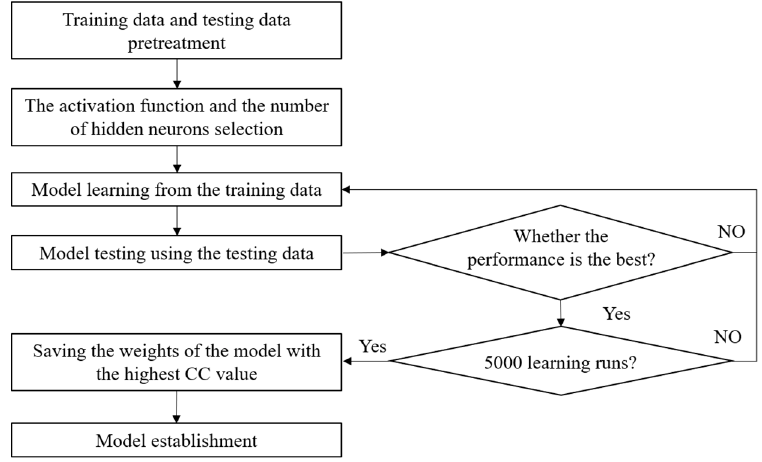
Figure 3. Flow chart of the ELM model establishment.